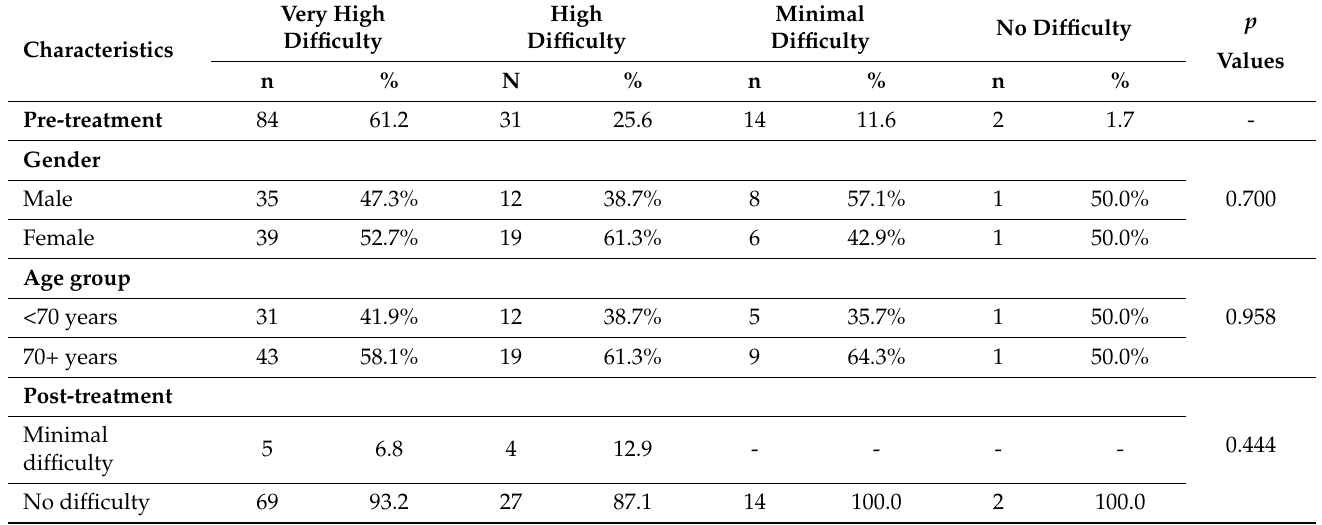
Table 3. The percentage distribution of patients with difficulty in recognizing a person they met according to pre- and post-treatment study group